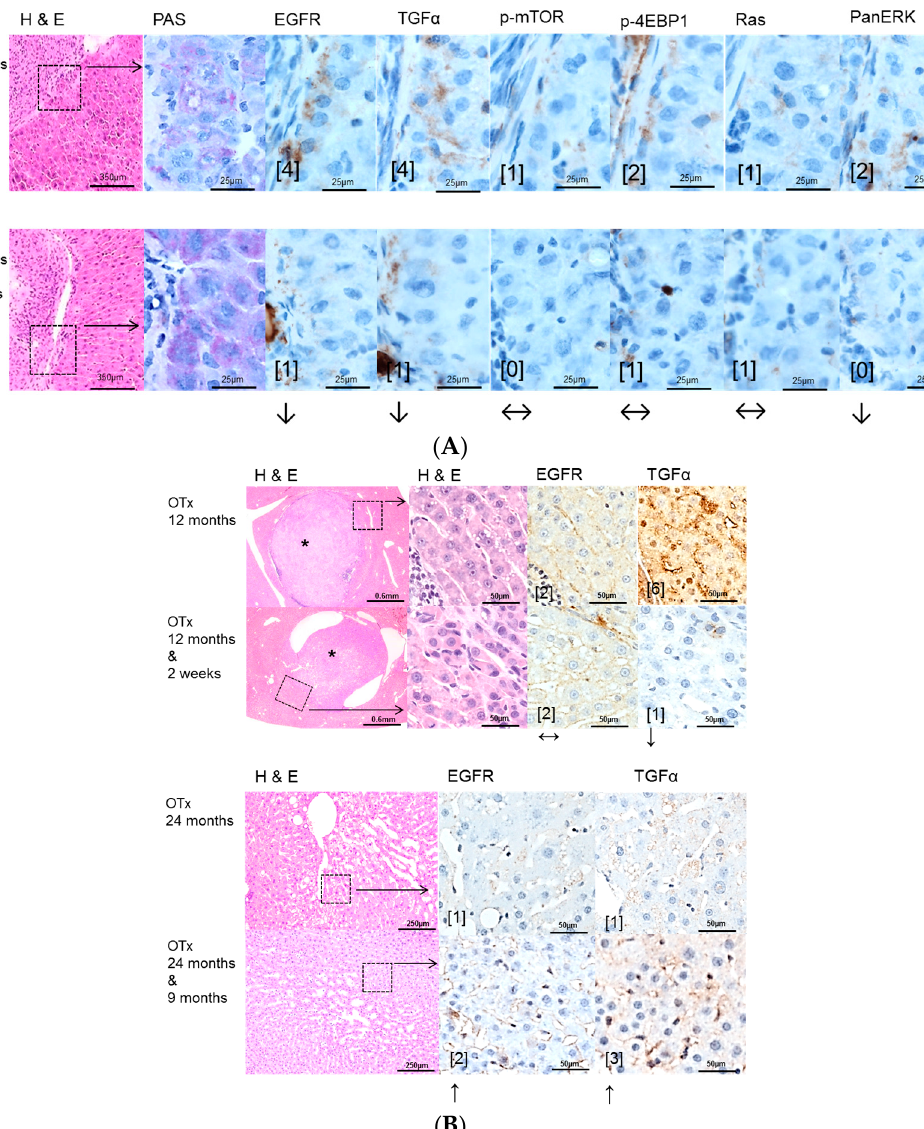
Figure 3. Effects of Gefitinib after intraportal transplantation of ovarian fragments in ovariectomized rats (OTX) and expression patterns of EGFR, TGF α and downstream signaling pathways in pre-neoplastic foci of altered hepatocytes (FAH) and neoplastic liver lesions. Gefitinib was administered daily for two weeks (20 mg/kg body weight) or 9 months (10 mg/kg), respectively. ( A ) Short-term experiments (three months). FAH of untreated rats (OTx 3 months) at the downstream level of transplanted ovarian fragments reveal loss glycogen storage (PAS) and a slight overexpression of EGFR and TGF α and also of downstream signaling with representative p-mTOR and PanERK, p-4EBP1 and Ras. After Gefitinib treatment for two weeks (OTx 3 months & 2 weeks), the EGFR and TGF α but not downstream signaling are slightly reduced; ( B ) Long-term experiments (12 and 24 months). Transplant tumors and associated FAH with unaltered EGFR but downregulated TGF α expression level after Gefitinib treatment for two weeks (OTx 12 months & 2 weeks) in comparison to untreated rats (OTx 12 months). Small HCAs (*) with upregulation of the EGFR and TGF α after Gefitinib treatment for 9 months (OTx 24 months & 9 months). Immunostaining scores are shown in brackets. Arrows correspond to ↑ upregulation, ↓ downregulation or ↔ unchanged expression level. Expression levels of immunostaining are given in brackets. Magnification: ( A ) 3 months/(3 months & 2 weeks) (H & E) 40×; marked area in dashed lines (PAS and immunostainings) 600×; ( B ) 12 months/(12 months & 2 weeks) (H & E) 40×; marked area in dashed line (H & E and immunostainings) 400×; 24 months/(24 months & 9 months) (H & E) 100×; marked area in dashed lines (immunostainings) 400×.